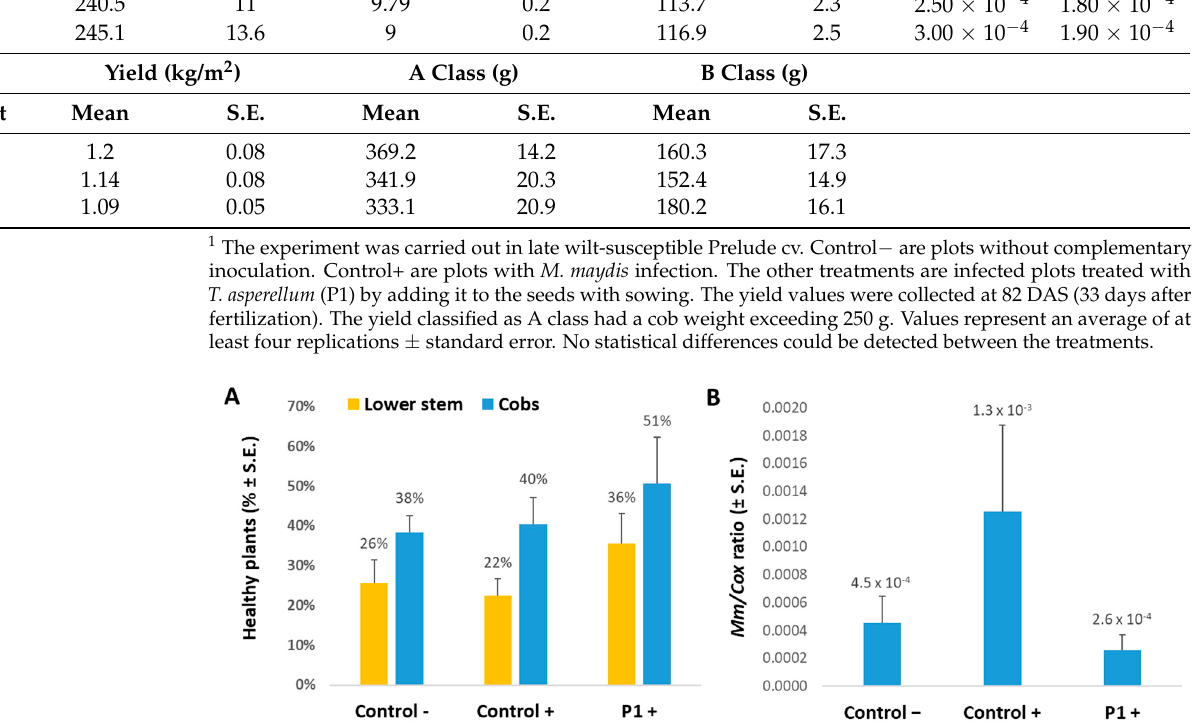
Figure 3. Bioassay of the Trichoderma asperellum (P1) secreted metabolites. The fungus liquid growth medium (P extract) was used to prepare a rich growth medium (PDA). The plates were used to test the maize post-flowering stalk rot complex [73]. This fungal group includes M. maydis, Macropho- mina phaseolina, and Fusarium verticillioides . The controls are regular water-based PDAs. Representa- tive plates’ photos were taken after six days.